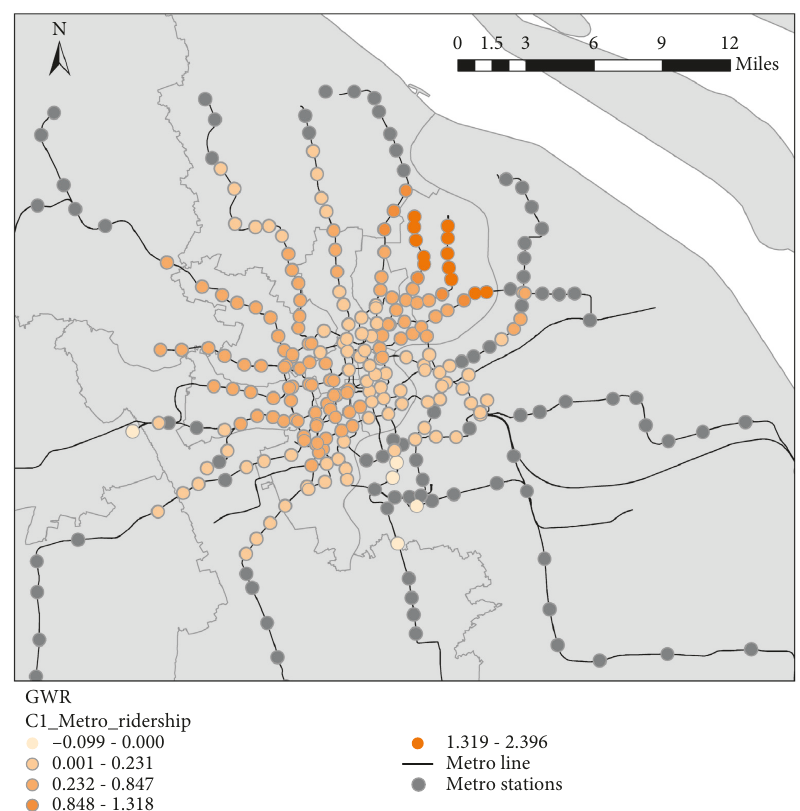
Figure 7: Spatially varying effect of the metro ridership on bike-sharing transfer ridership.